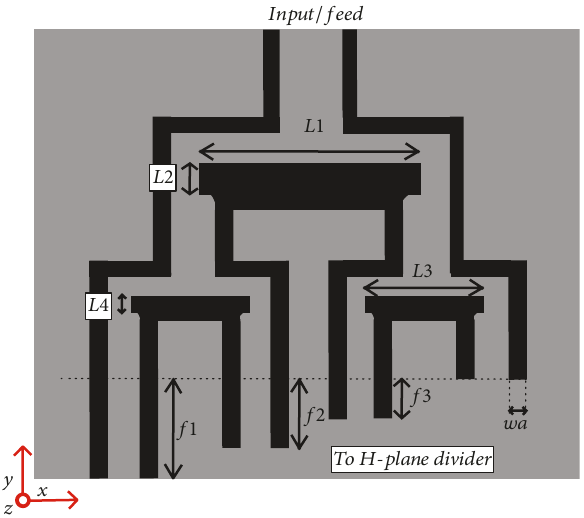
Figure 3: Internal structure of the primary feed divider.